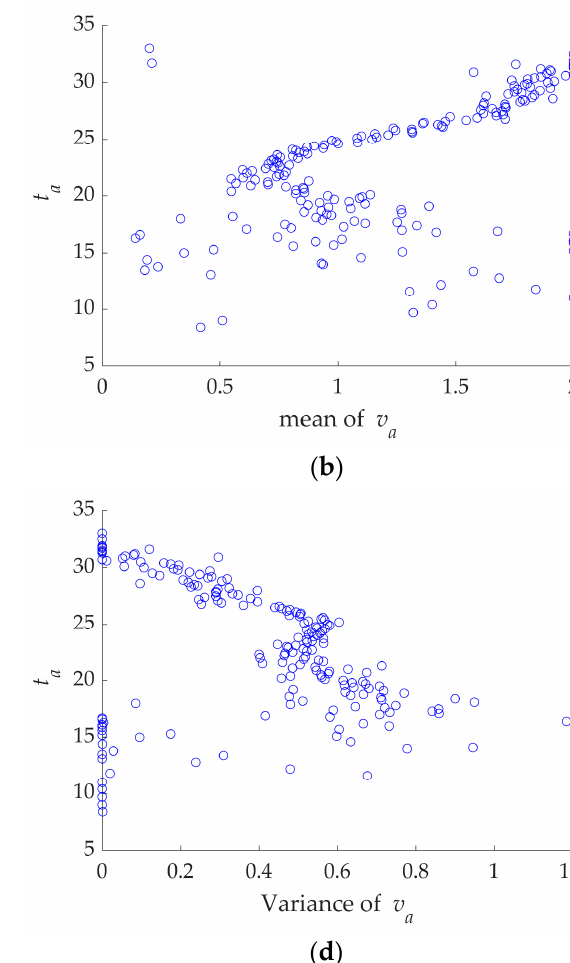
Figure 13. Average interval based on the mean of the left and right endpoint values of air velocity for all air-velocity adjustable intervals. (The color line represents the air velocity adjustment range of each temperature)